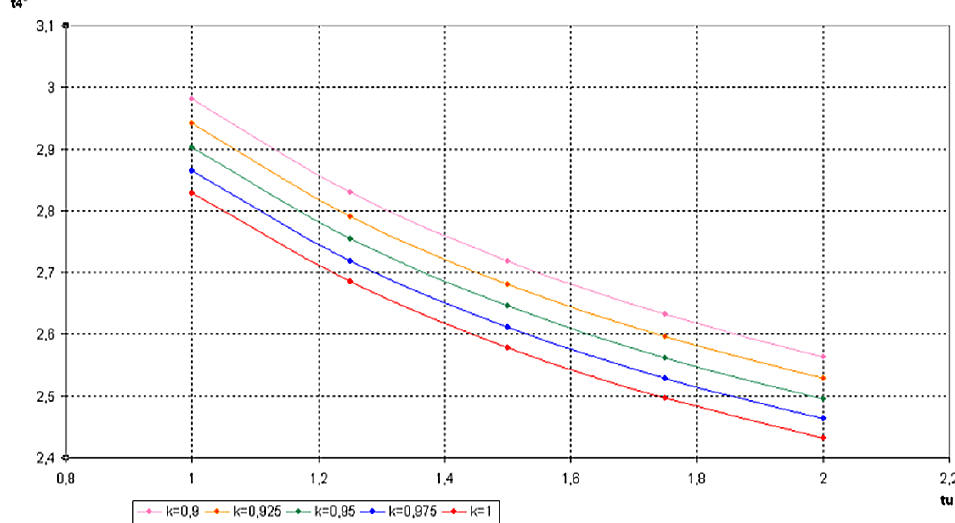
t as a function of t 4